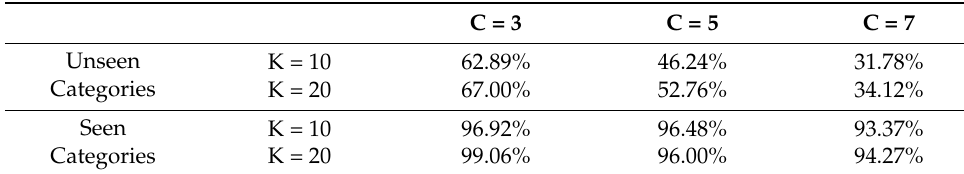
Table 3. Recognition accuracies for unseen categories and seen categories under different setting conditions.